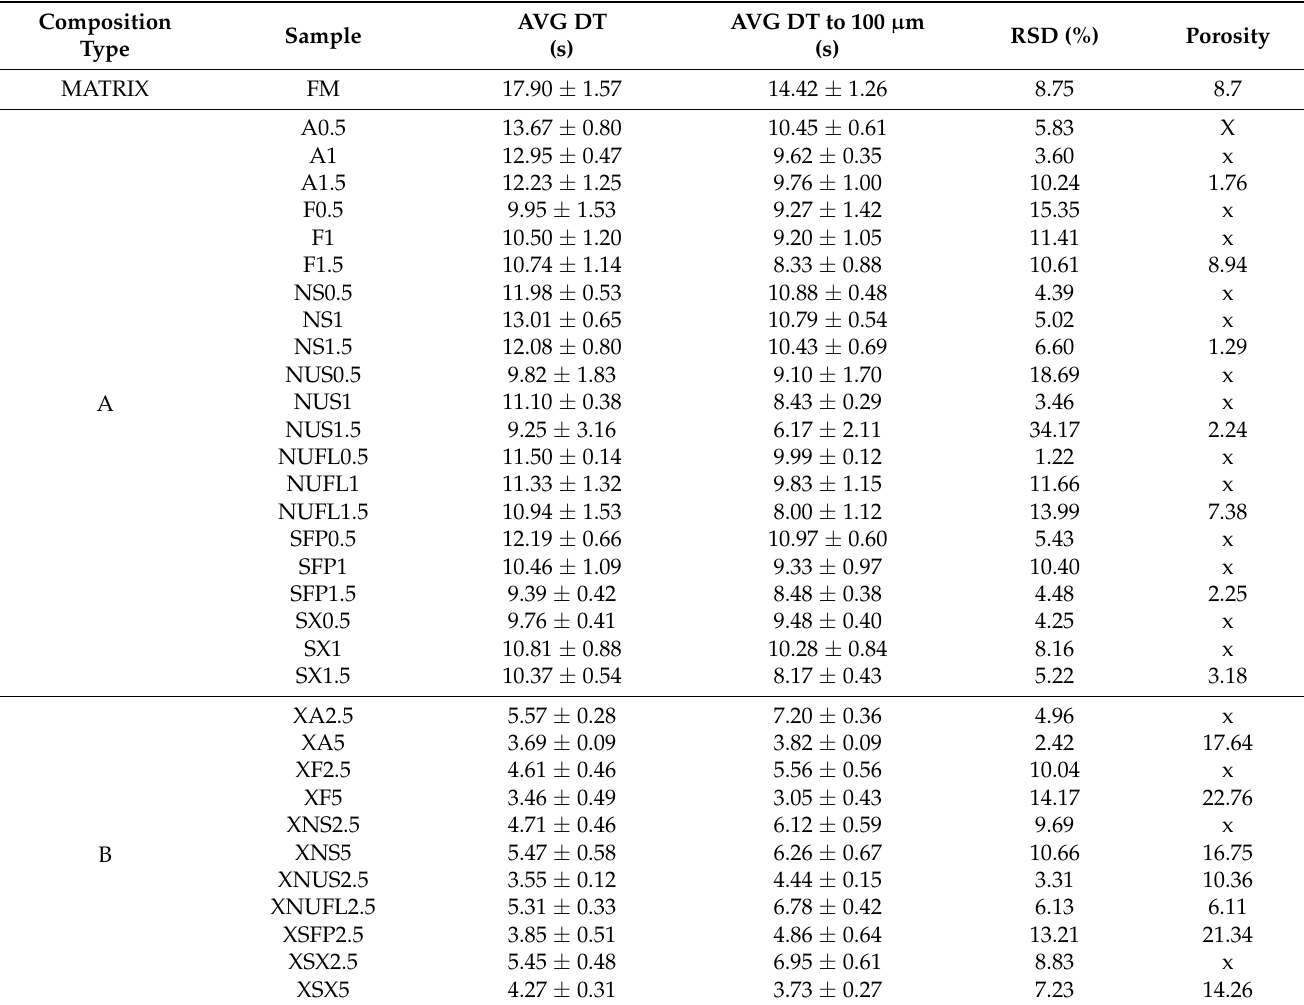
Table 5. Results of DT and micro-CT porosity